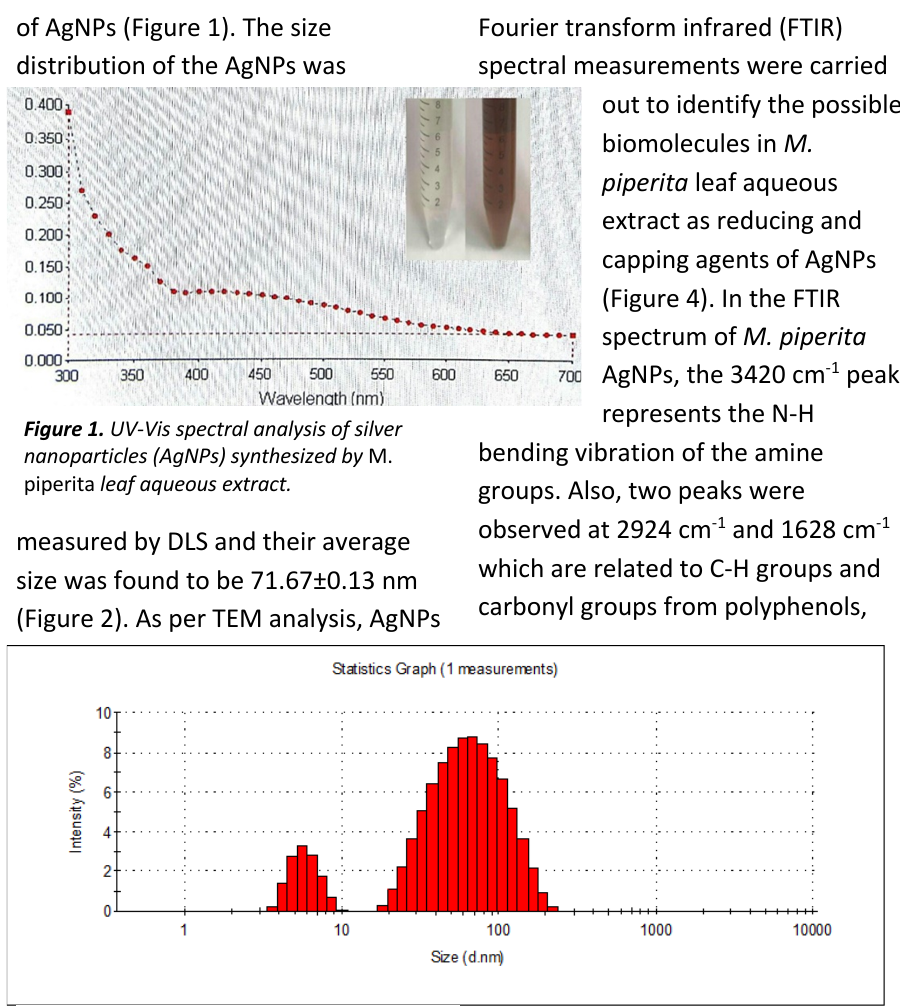
Figure 2. Particle size of M. piperita AgNPs.